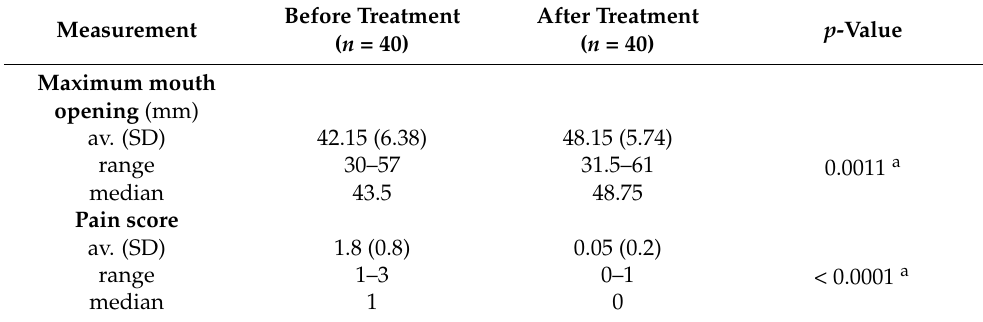
Table 5. The average values of maximum mouth opening and pain scores before and after the end of the treatment.